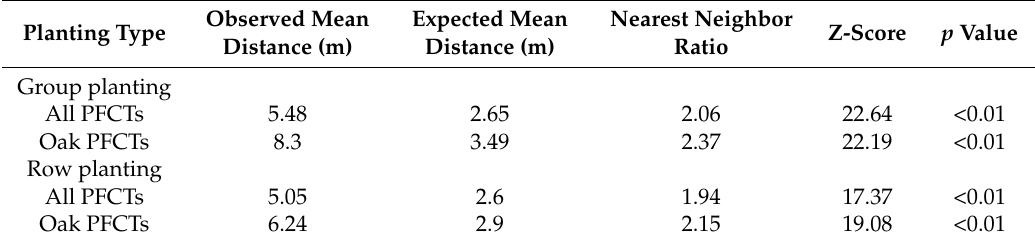
Table 5. Results of the Nearest Neighbor Analysis on the distribution of PFCTs by combining all five stands in group and row planting categories (m = meter).